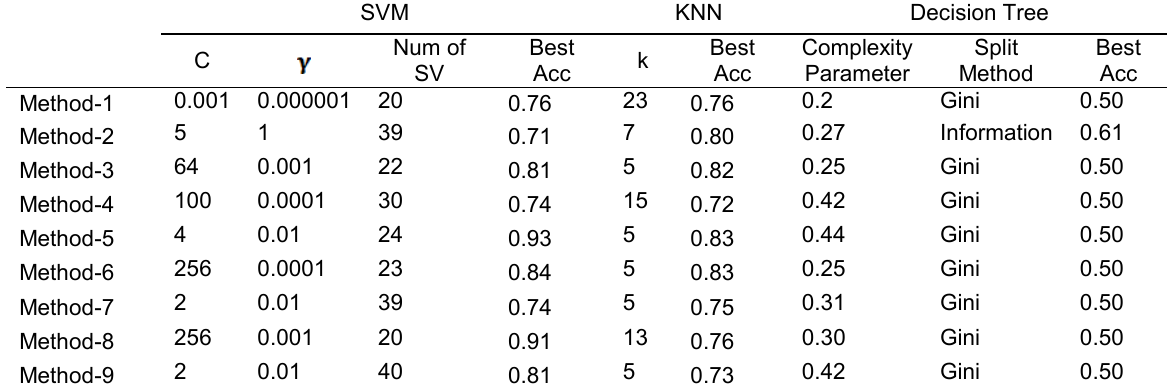
Table 7. Tuned parameters and best cross-validation accuracy of classification technique for pelvis rotation.